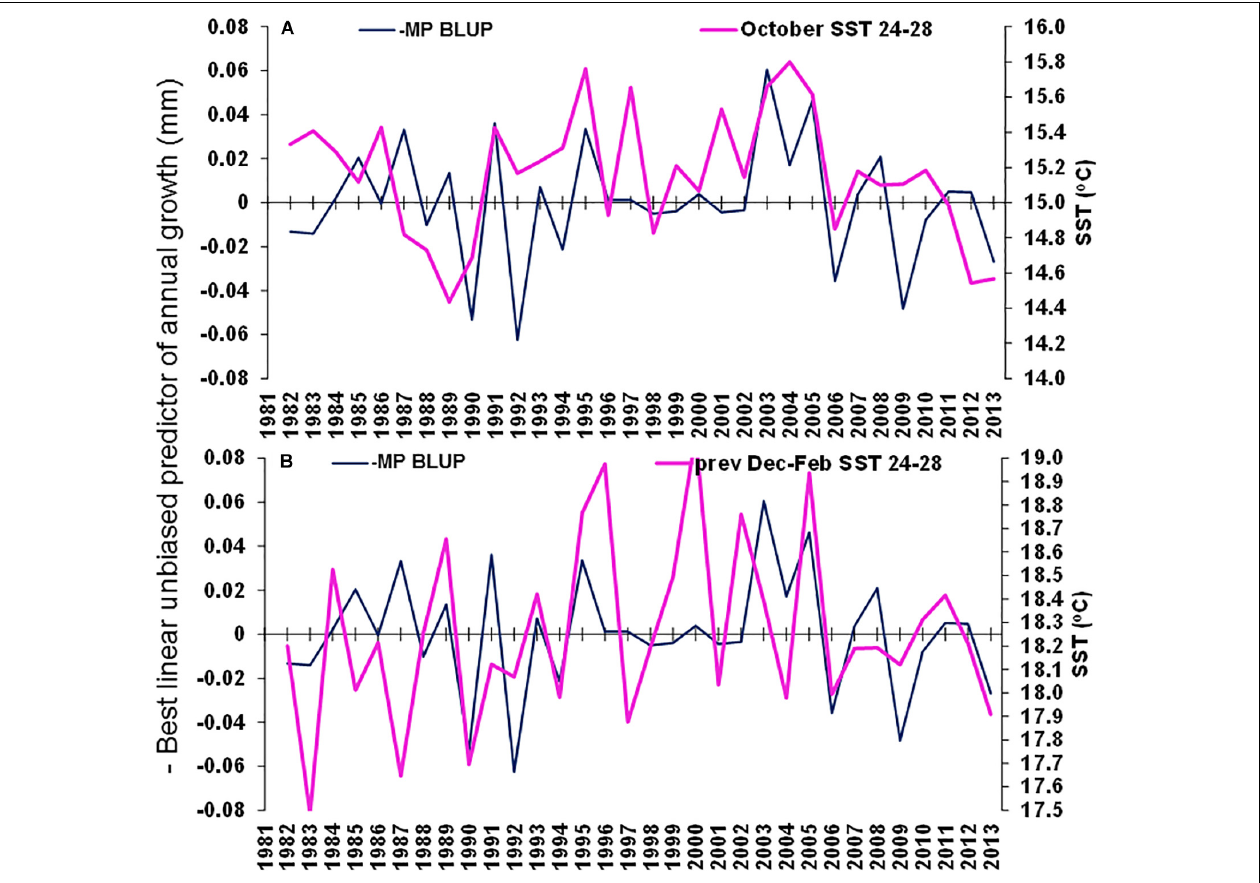
FIGURE 9 | Merluccius paradoxus (MP) caught in Namibia best linear unbiased predictor (BLUP) of annual growth from otolith increments (negative to demonstrate negative correlations) (blue) and (A) October Sea Surface temperature (SST) in the area –24.0 to –28.0 latitude, 13.0 to 15.0 longitude and (B) previous December to February SST in the area –24.0 to –28.0 latitude, 13.0 to 15.0